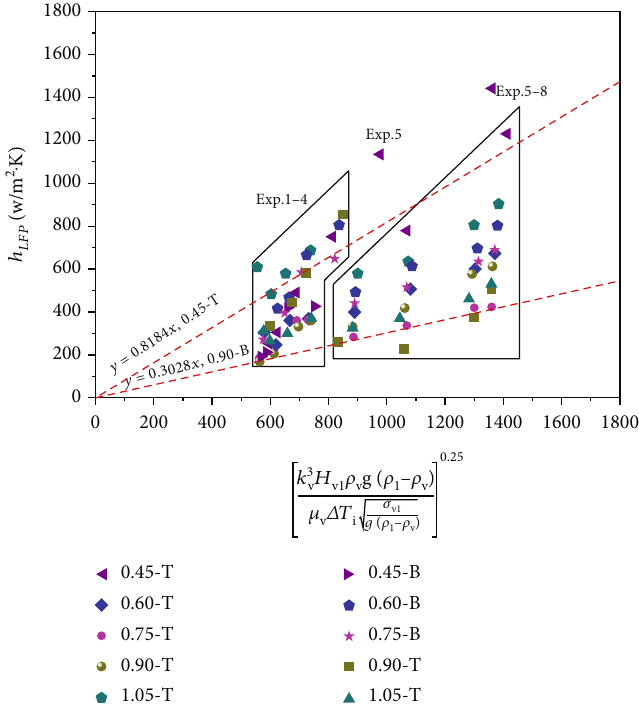
p ffiffiffiffiffiffiffiffiffiffiffiffiffiffiffiffiffiffiffiffiffiffiffiffiffiffiffi ρ − ρ Þ / μ Δ T σ / g ð ρ H g ð ρ vl i vl v v l v v